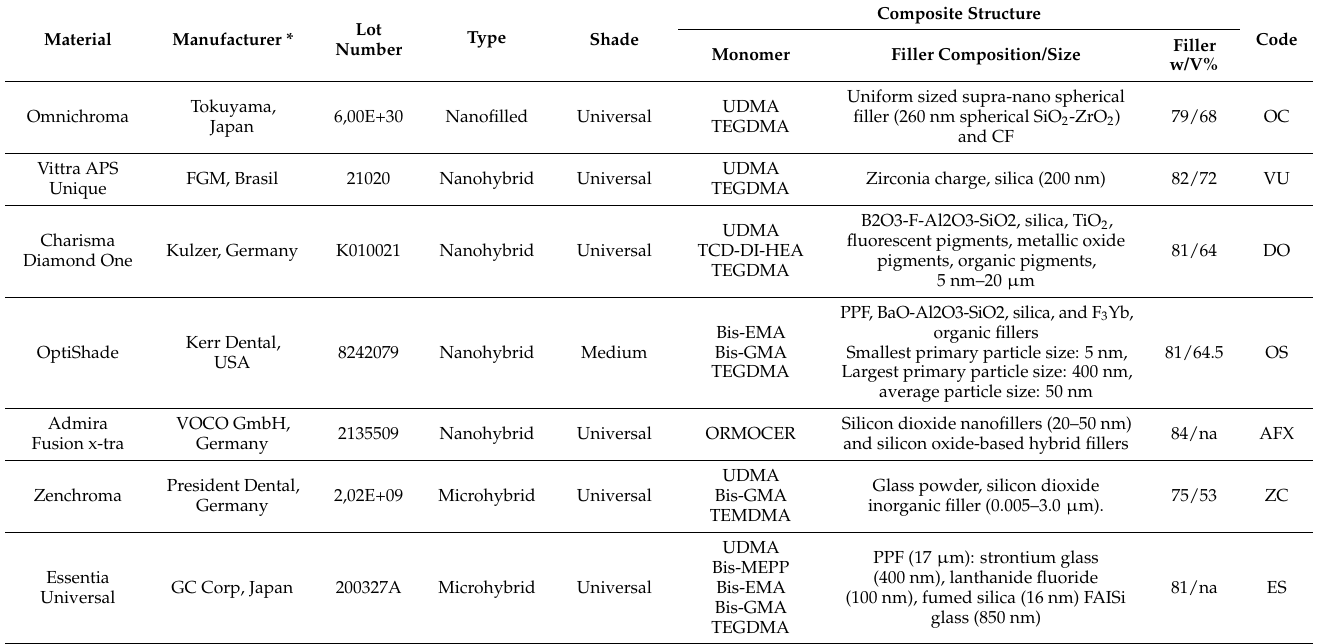
Table 1. The brand names, manufacturers, lot numbers, shades, monomers, filler types, and filler loadings of the